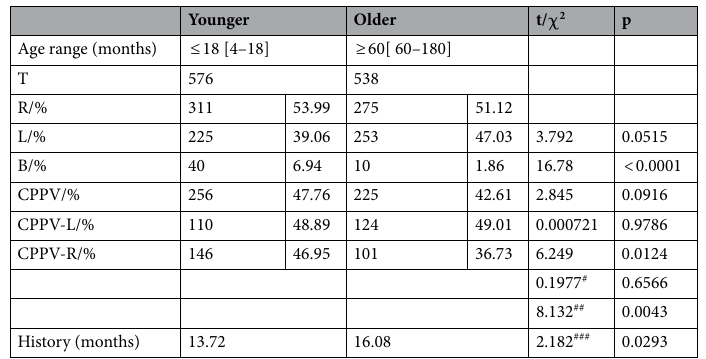
Table 3. Clinical details of younger and older boys included in the study. # CPPV-R vs. CPPV-L in younger